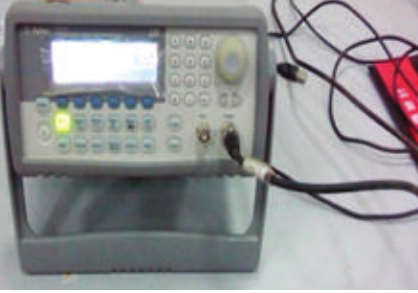
Figure 11: Signal